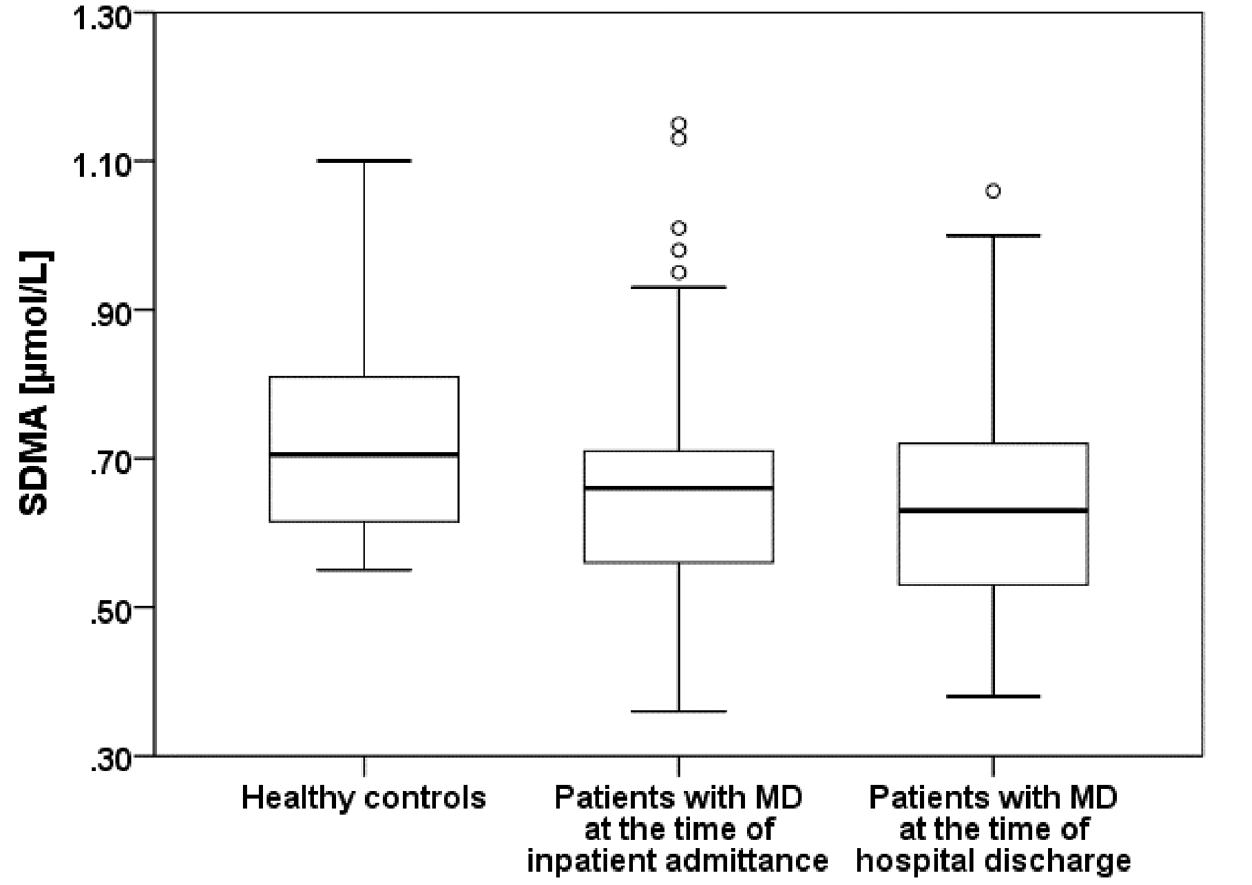
Fig 4. Comparison of Symmetrical Dimethylarginine (SDMA) between healthy contols and patients with major depression